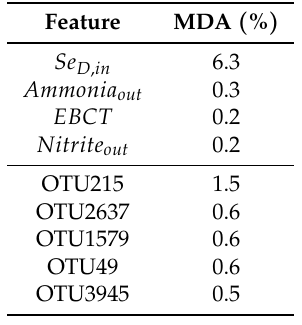
Table 5. Mean decrease in accuracy (MDA) feature importances for hierarchical clustering.